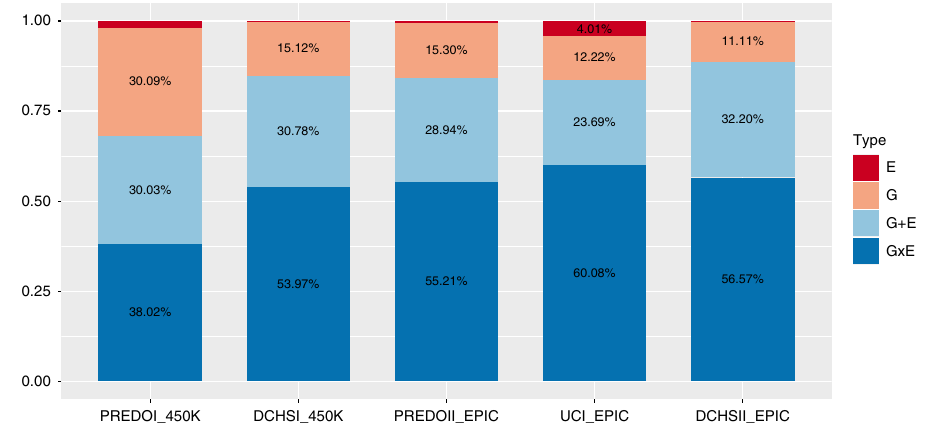
Fig. 5 VMR analysis in PREDO I and replication datasets. Percentage of models (G, E, GxE or G + E) with the lowest AIC explaining variable DNA methylation in PREDO I (450 K), DCHS I (450 K), PREDO II (EPIC), UCI (EPIC) and DCHS II (EPIC)